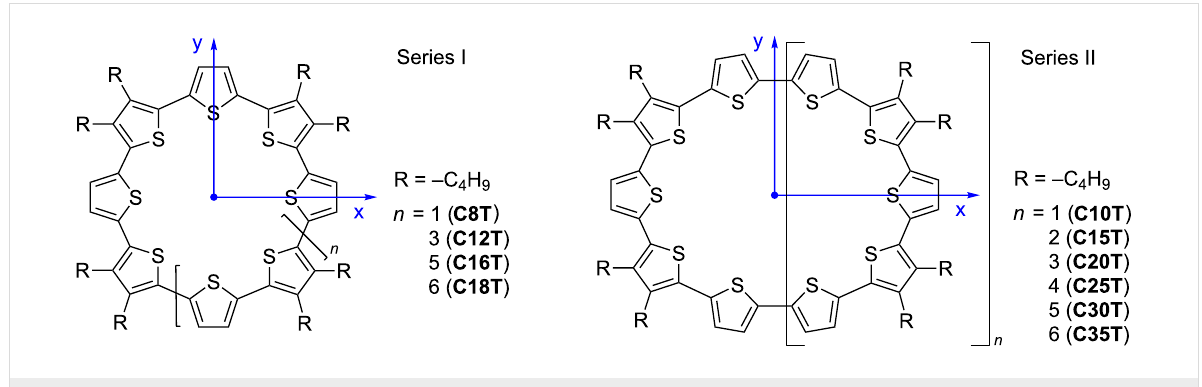
Scheme 1: Chemical structure of the oligothiophene macrocycles (series I and II). The coordinate system used in the theoretical description is